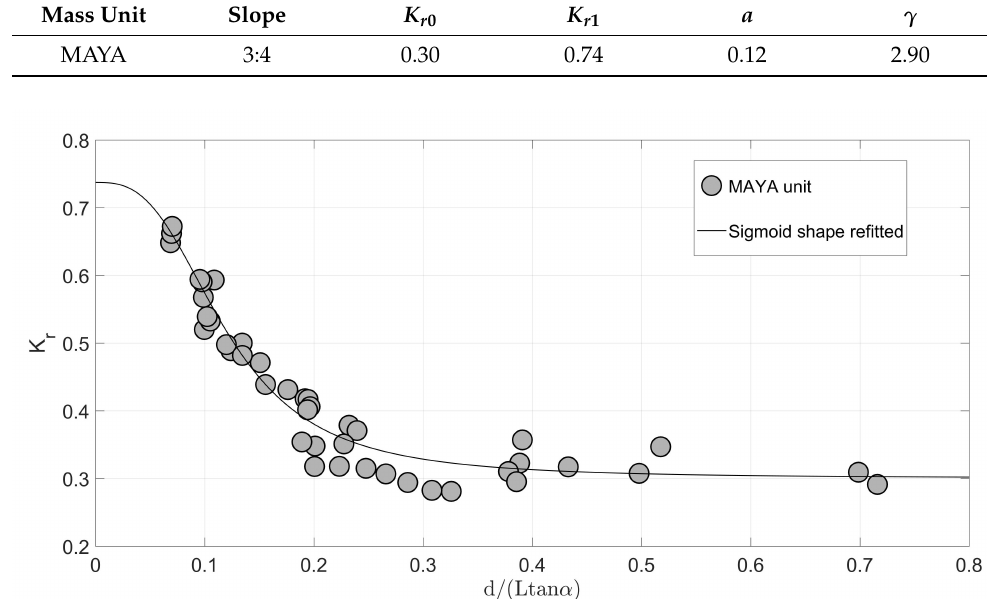
Table 6. Values of the sigmoid function parameters refitted for MAYA units and a 3:4 front slope.